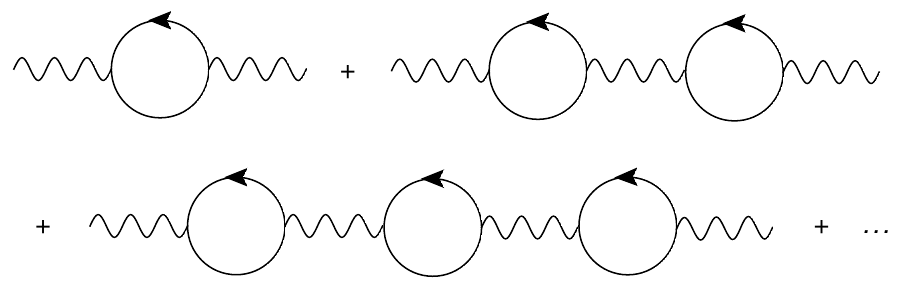
Figure 11 . Extrapolations of the free energy from the Dirac fermion point (tan (cid:0) 1 ( g O (2) point (tan (cid:0) 1 ( g s ) = (cid:25)= 2).